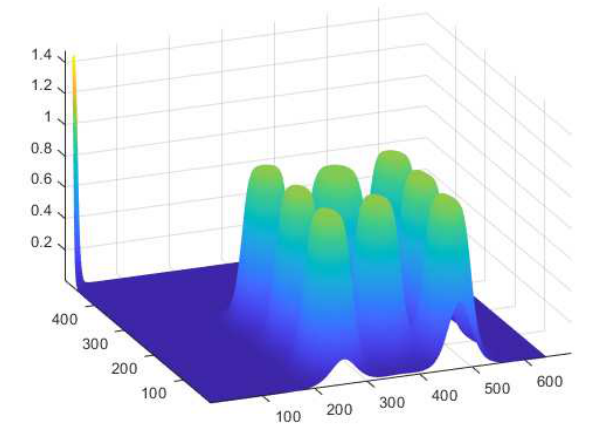
Figure 14. 3D mask of the observed area of instruments.